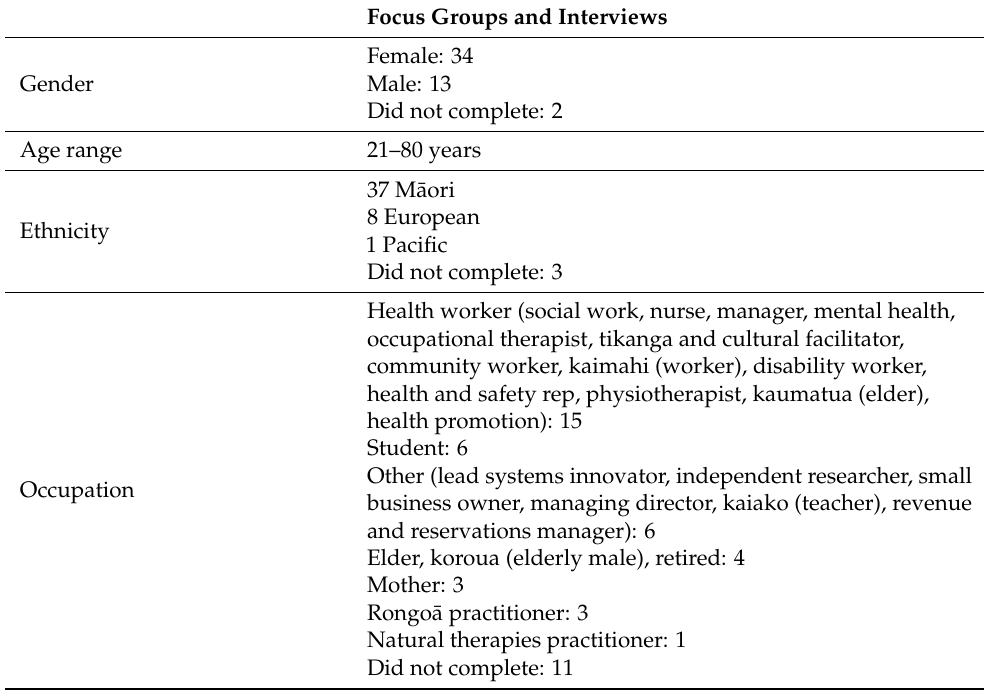
Table 1. Participant demographics: this table presents the participant demographic information by gender, age, ethnicity and occupation. Focus Groups and